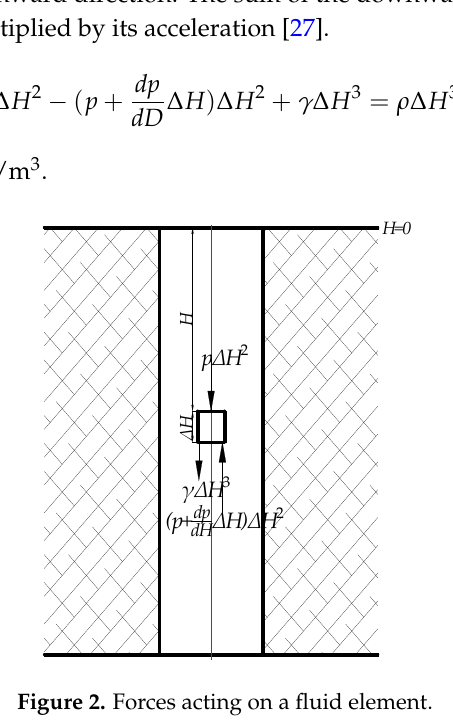
Figure 2. Forces acting on a fluid element.